Question: In one sentence, what is this figure communicating?
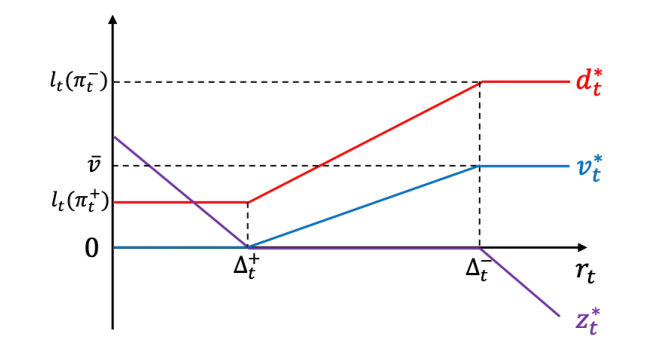
Answer: Procrastination threshold policy for δt < yt < τt.